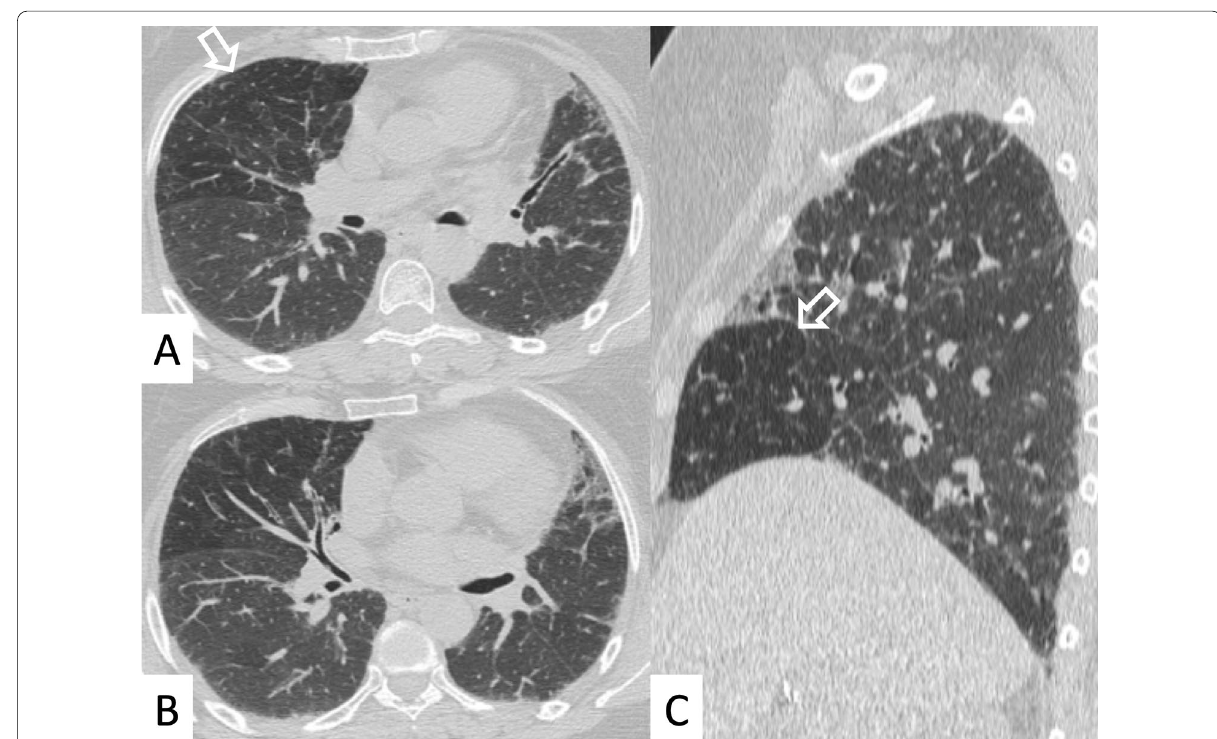
Fig. 25 LIP pattern with inhomogeneous attenuation of pulmonary parenchyma. Nodules, due to the peribronchovascular locations, may reproduce inhomogeneous lung attenuation, due to air-trapping mechanisms (white empty arrows in A , C )